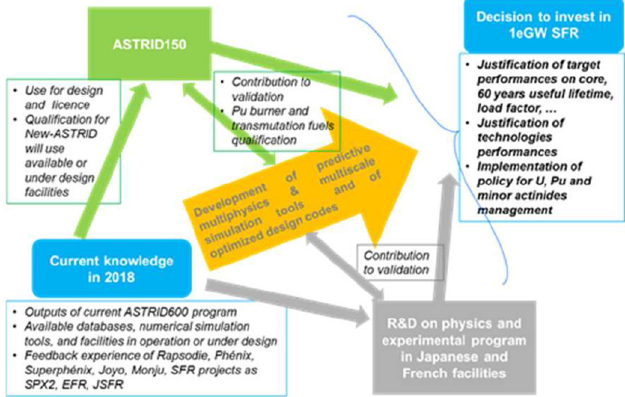
Fig. 1. Objectives of a combined ASTRID150 and a simulation program for scaling up to a commercial size reactor.